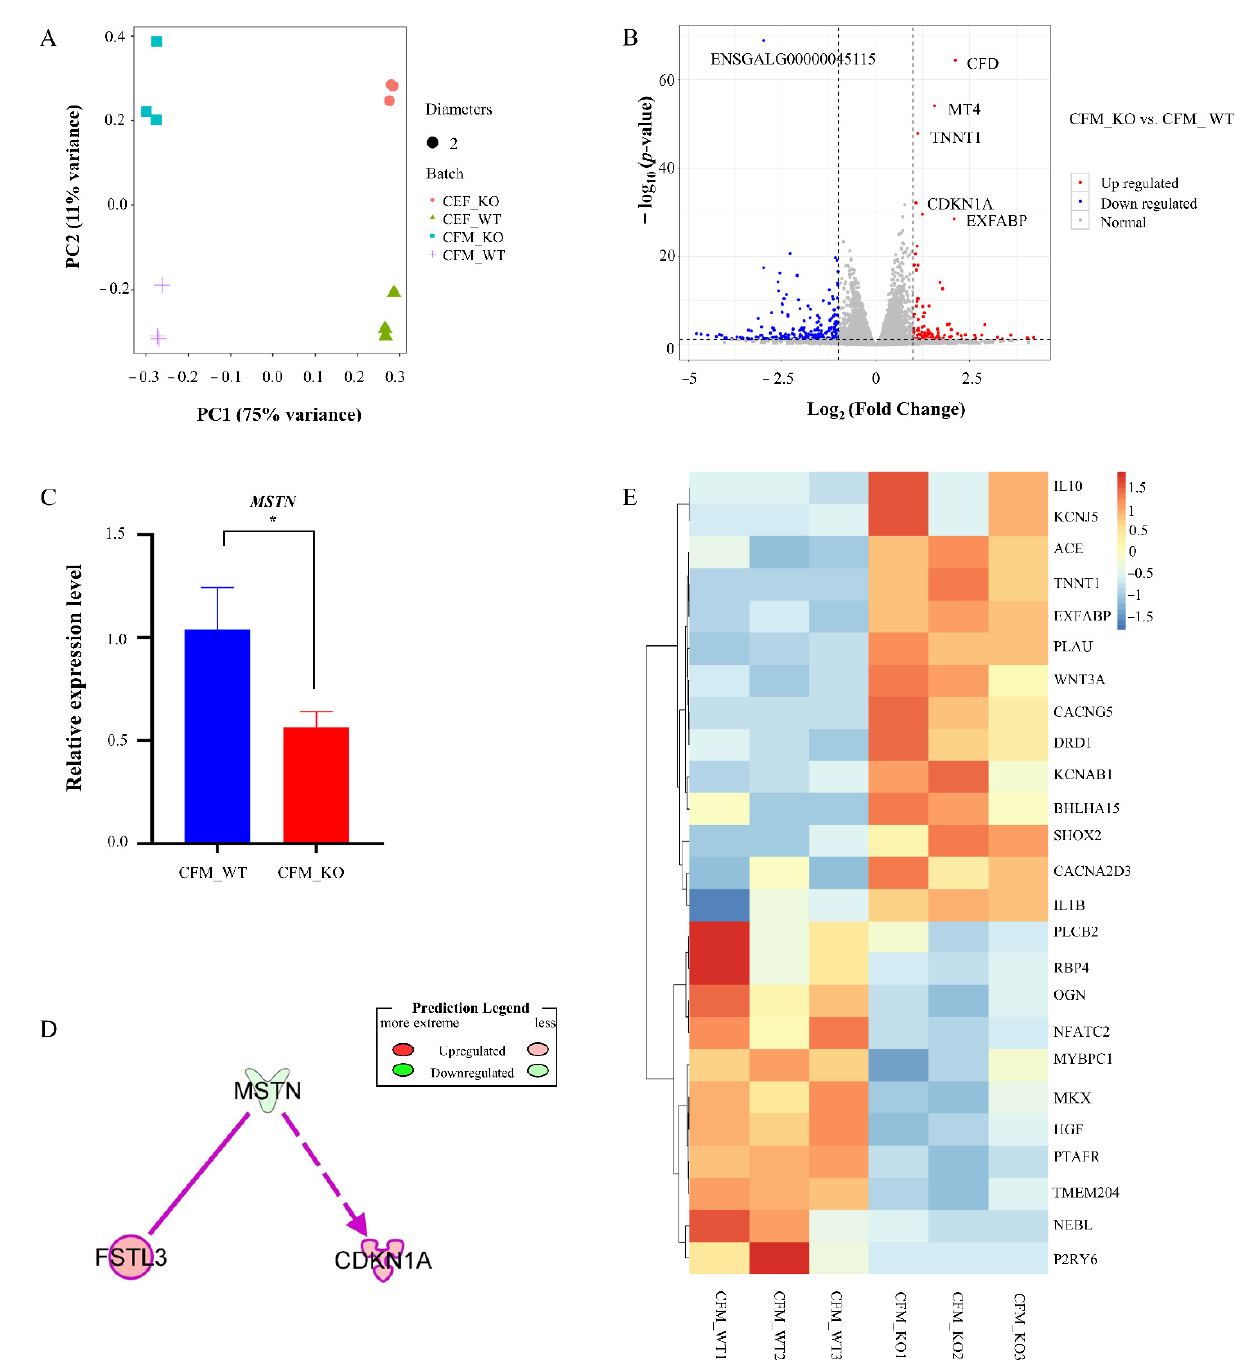
Figure 2. Differentially expressed genes (DEGs) analysis. ( A ) Principal component analysis for all primary chicken cells. Principal component 1 (PC1) and principal component 2 (PC2) were identified by logarithm transformation in DESeq2. ( B ) Volcano plot reveals significant DEGs in the comparison of CFM_KO vs. CFM_WT. ( C ) Expression level of MSTN in CFM_WT and CFM_KO groups detected by real-time PCR (* p < 0.05). ( D ) DEGs associated with MSTN in the CFM_KO vs. CFM_WT groups. ( E ) Heatmap hierarchical clustering revealed the DEGs related to skeletal muscle tissue development in CFM_KO vs. CFM_WT.